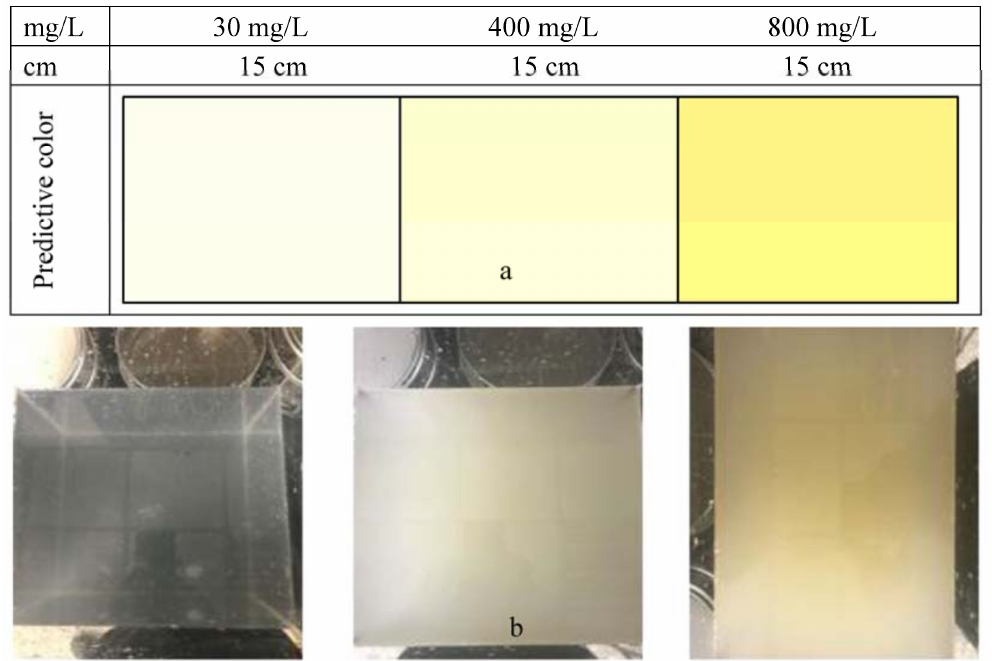
Figure 7. ( a ) Calculation results of water landscape color under different sediment concentrations picture (experimental depth 15 cm). ( b ) Real picture of water landscape color under different sediment concentrations (experimental depth 15